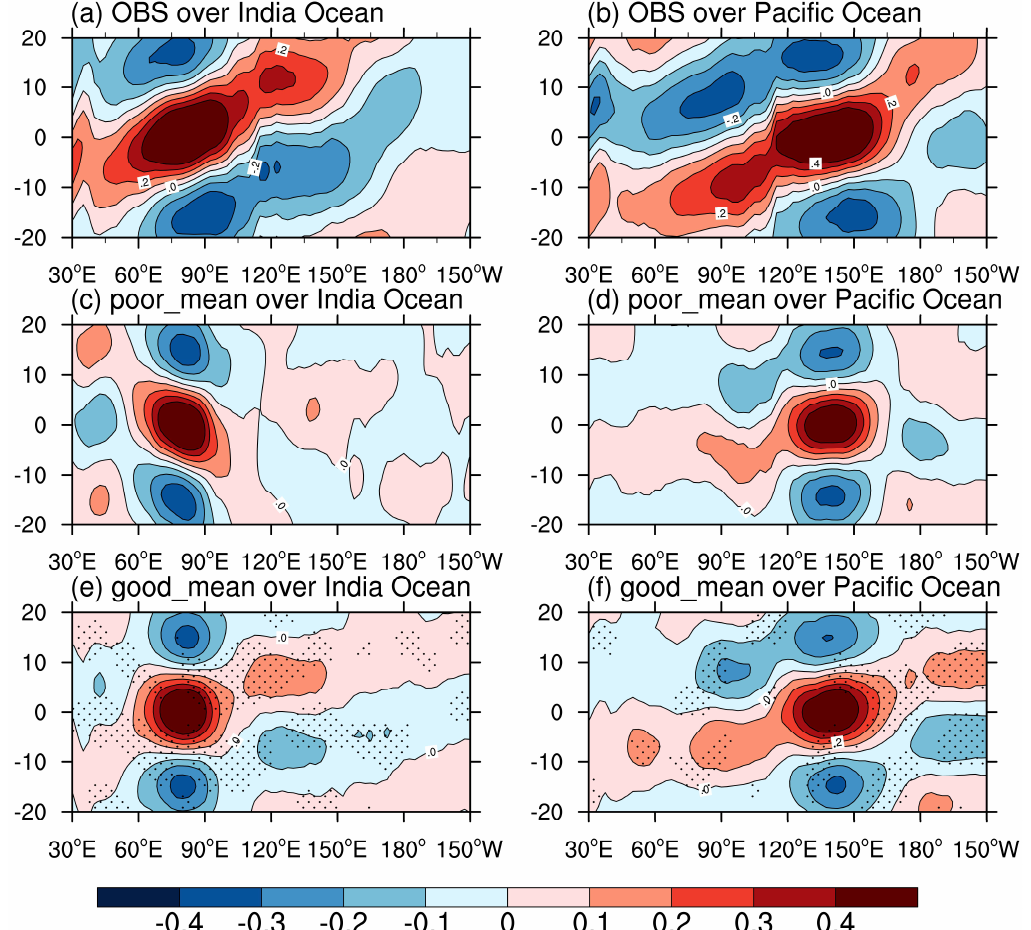
Figure 8. Boreal winter (November–April) Lag-longitude cross section of the correlation coefficient of 20–100 day filtered OLR anomalies against the area-averaged time series of itself in observation ( a and b ), poor simulations ( c and d ) and good simulations ( e and f ) at the reference area of equatorial India Ocean (5° S–5° N; 75°–85° E) (left column) and Pacific Ocean (5° S–5° N; 130°–150° E) right column). The regressed coefficient is averaged over 10° S–10° N. ( d ) and ( e ) are dotted where the difference between composite of good and poor simulations reach 90% confidence level.